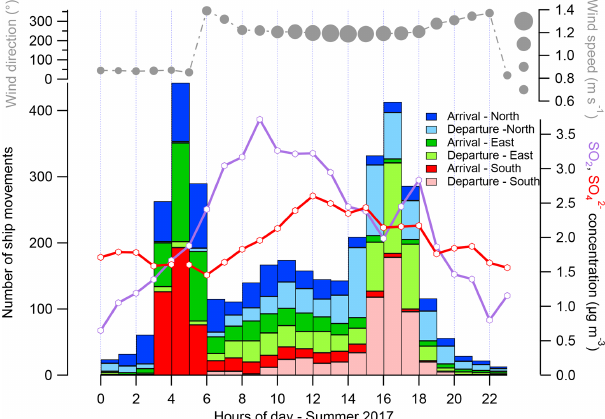
Figure 11. Diurnal profile of cumulative number of ship movements for the summer 2017 period, coloured according to the basin loca- tion (blue for north, green for east, red for south) and the type of movement (dark-coloured for arrival, light-coloured for departure). Diurnal profiles of SO 2 in purple, SO 2 − in red and wind direction 4 in grey (the size of dots is proportional to the wind speed intensity) are also represented. The data points linked to low speed conditions ( < 0.5ms − 1 ) were filtered out from the